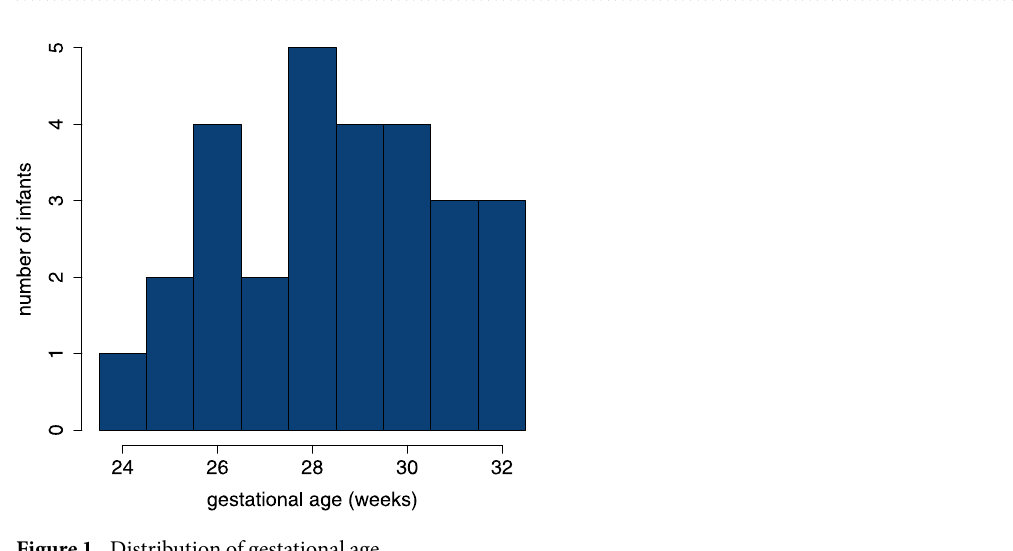
Figure 1. Distribution of gestational